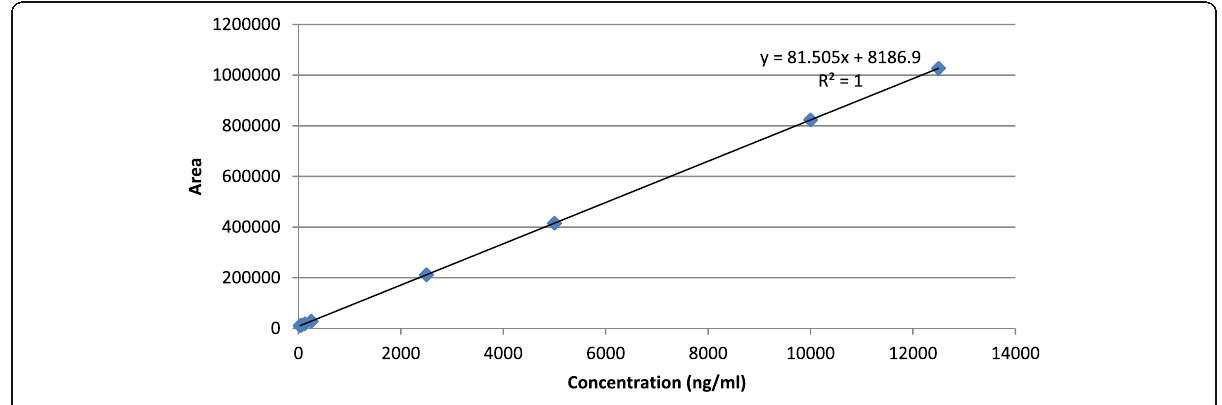
Fig. 8 Calibration plot of naringenin in brain tissue of